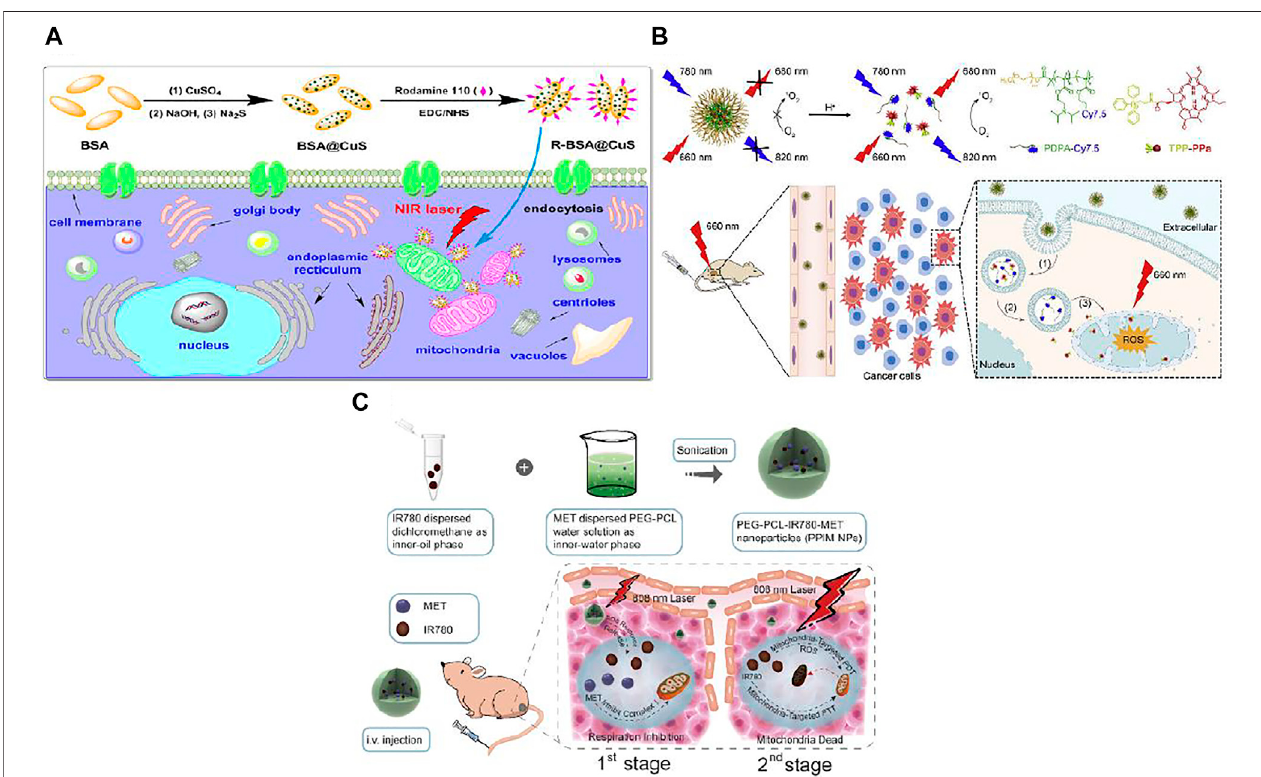
FIGURE 3 | (A) CuS nanoparticles were in situ synthesized in BSA templates with the conjugation of rhodamine 110 dyes to prepare mitochondria-targeted and photothermalR-BSA@CuSnanocomposites,resultinginanenhancedphotothermaltherapeuticef fi cacyofcancercells via destroyingtheirmitochondriaandweakening their heat tolerance. Reproduced with permission from Tong et al. (2021). Copyright (2021) Wiley-VCH. (B) Schematic illustration of M-TPPa for dual-stage precisely targeting of early endosome and mitochondria to amplify photodynamic therapy, mainly concludes three steps: (1) M-TPPa keepss silent in blood circulation, and can bequickly disassembled intheacidicenvironmentofearly endosome (pH 6.0 – 6.2) toactivatethe fl uorescence signals ofdye-conjugated polymerand photoactivity of photosensitizer upon endocytosis; (2) the released cationic TPPa molecules rapidly diffuse into cytoplasm; (3) the cytosolic TPPa targets mitochondria rapidly